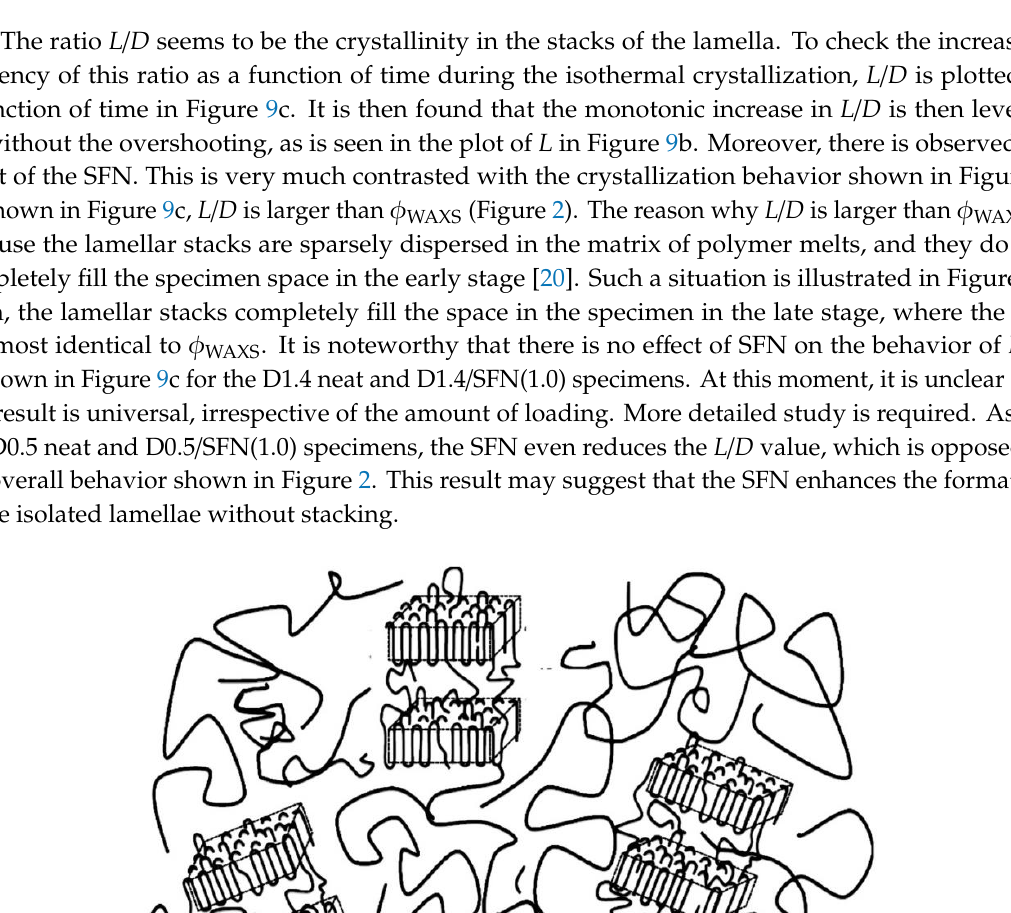
Table 3 . SAXS results for the isothermal crystallization at 110 °C .